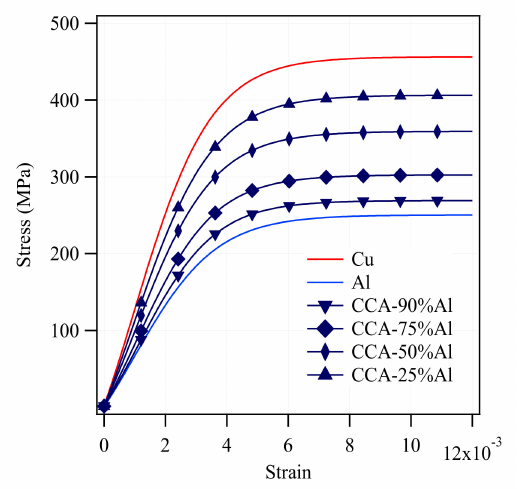
Figure 7. Simulation stress-strain curves of CCA samples of four different volume